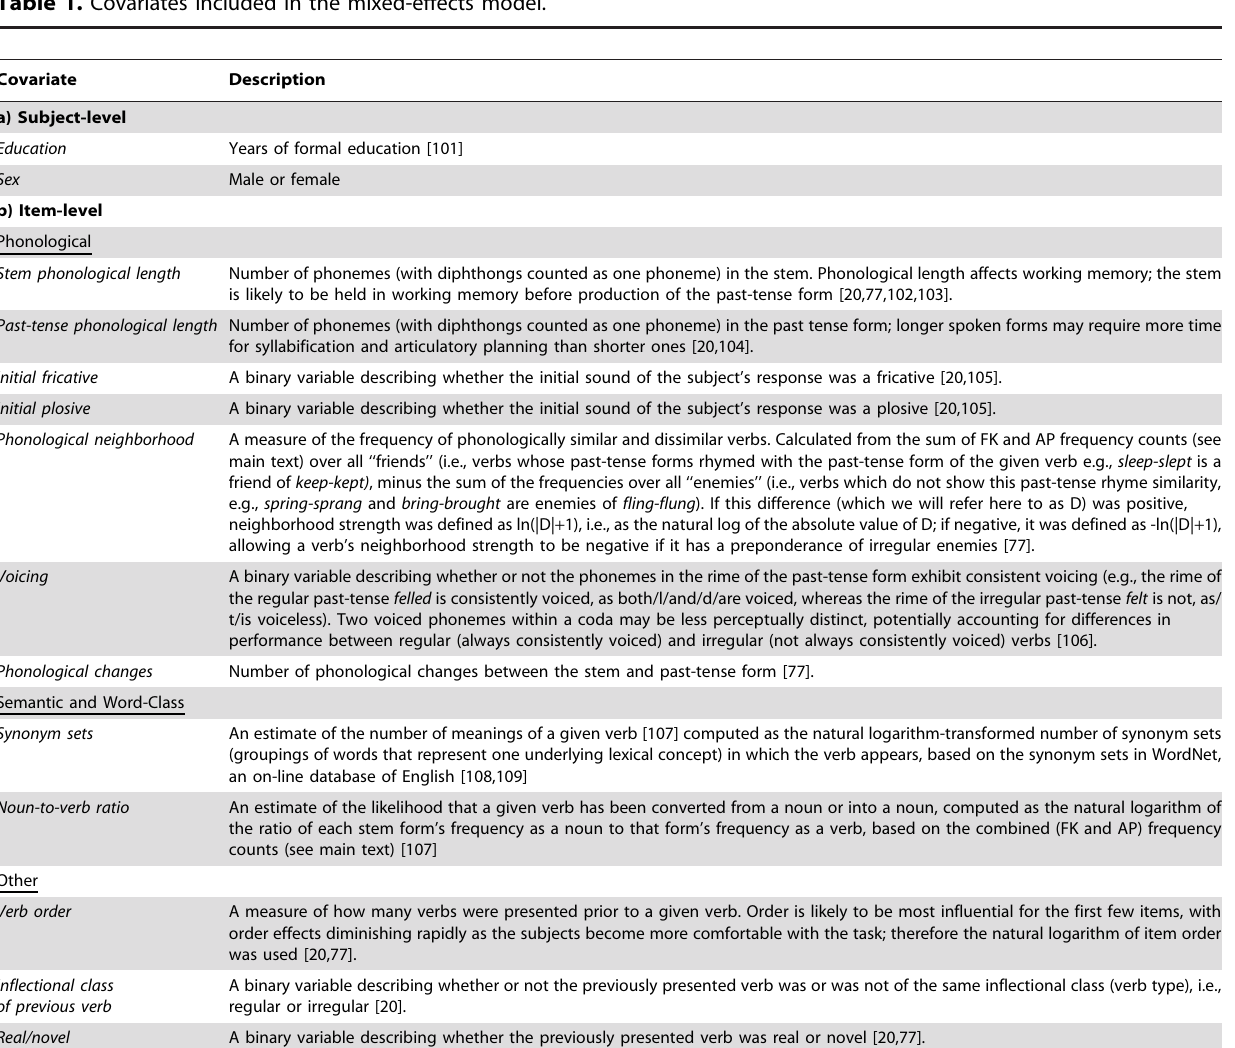
Table 1. Covariates included in the mixed-effects